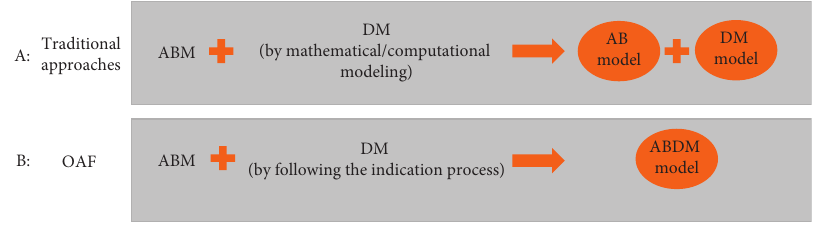
Figure 21: Traditional integration of ABM and DM vs. OAF.